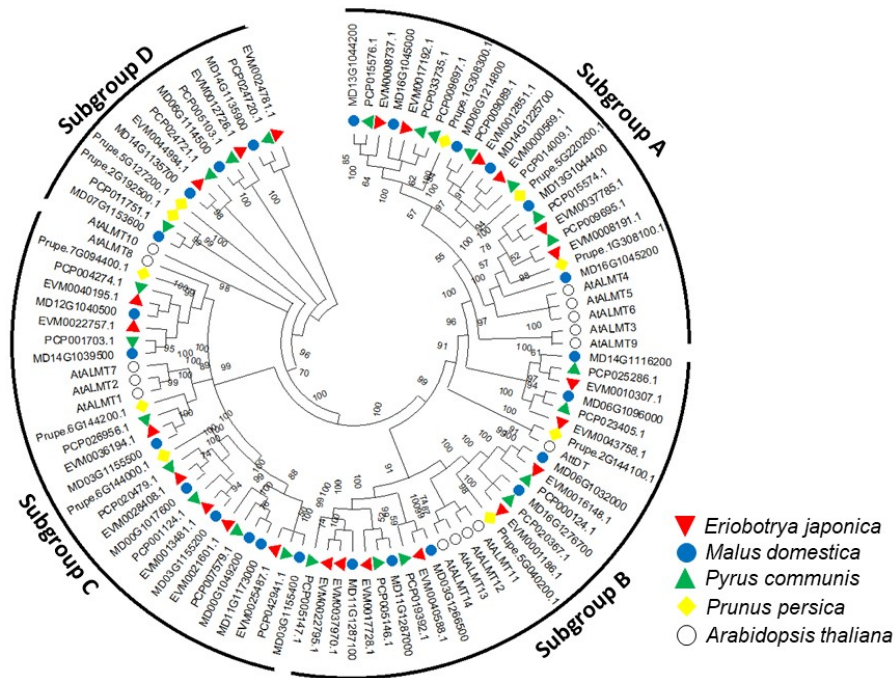
Figure 2. ( A ) Prediction of subcellular localization of EjALMT proteins. Higher signal levels are shown as red, lower signal levels are indicated as blue, while white color indicates no available data. Abbreviations: Nucl–Nucleus; Cyto–Cytonu- clear; Mito–Mitochondria; Vacu–vacuole; Chlo–chloroplast; E.R.–endoplasmic reticulum; Plas–plasma membrane; Golgi– golgi apparatus; Pero–peroxisome; Extra–extracellular. ( B ) Conserved domain analysis of ALMT genes in loquat genome.